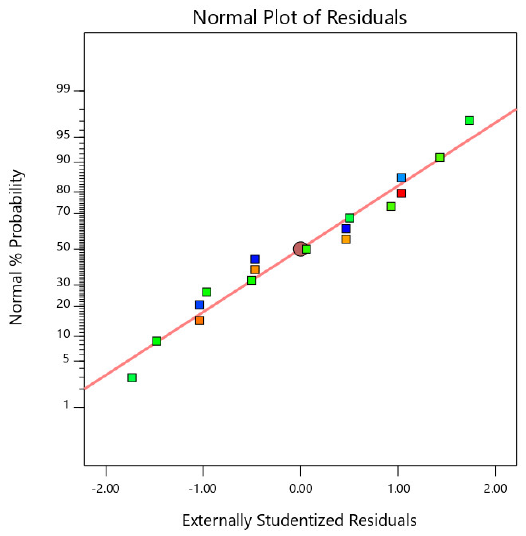
Figure 8. Normality test diagram.